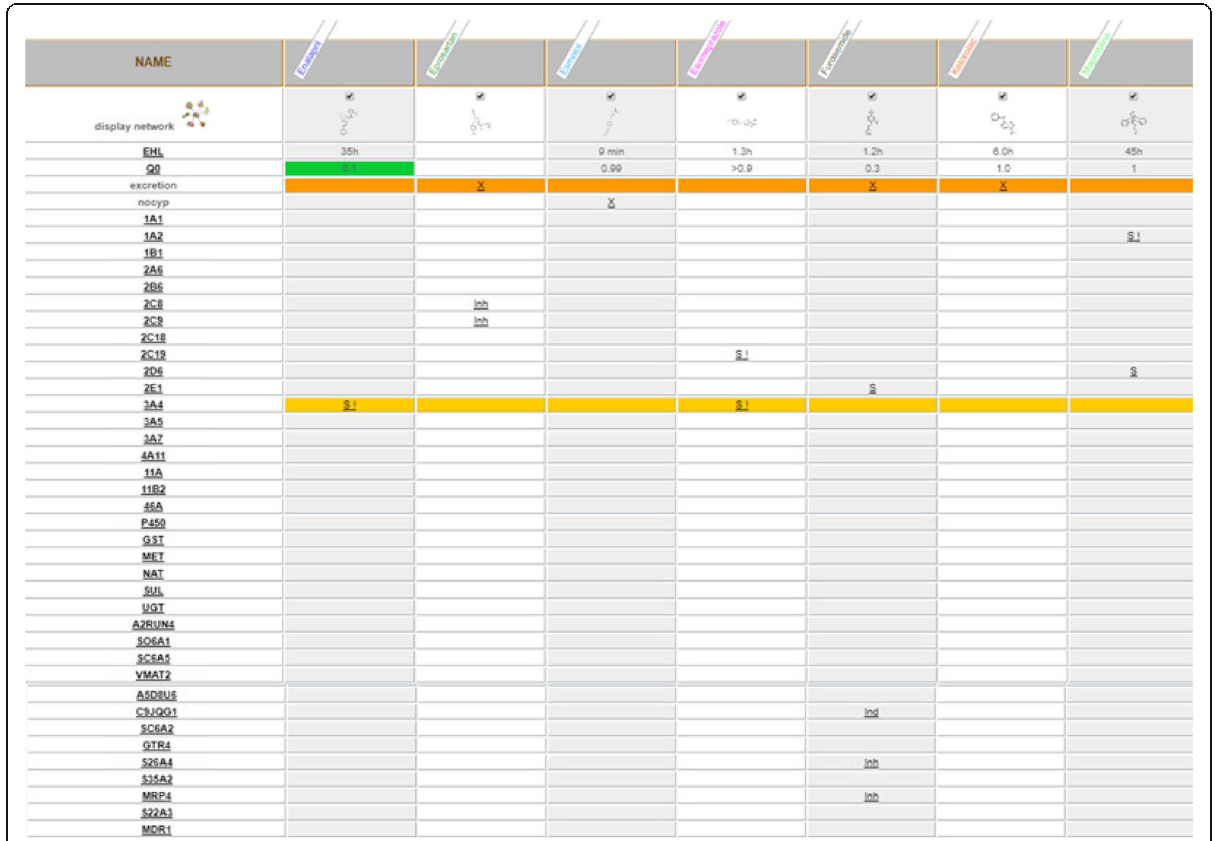
Fig. 10 Drug-drug interaction involved in optimized polytherapy for hypertension, prophylactic therapy for chronic migraine and episodes of acute attacks optimization of previous therapy. From left to right, in the first column there is the list of drug metabolizing enzymes, one for each row, each following column represent a drug the relationship between a drug and an enzyme/transporter is indicated by the symbol ‘ S ’ for substrate, ‘ Inh ’ for inhibitor and ‘ Ind ’ for inducer. The colours of different rows indicate the increase in metabolic pressure passing by the various colours ranging from yellow to orange, to red, to dark red. X = link to related scientific articles about the items in the first column accessible through the related page at the website